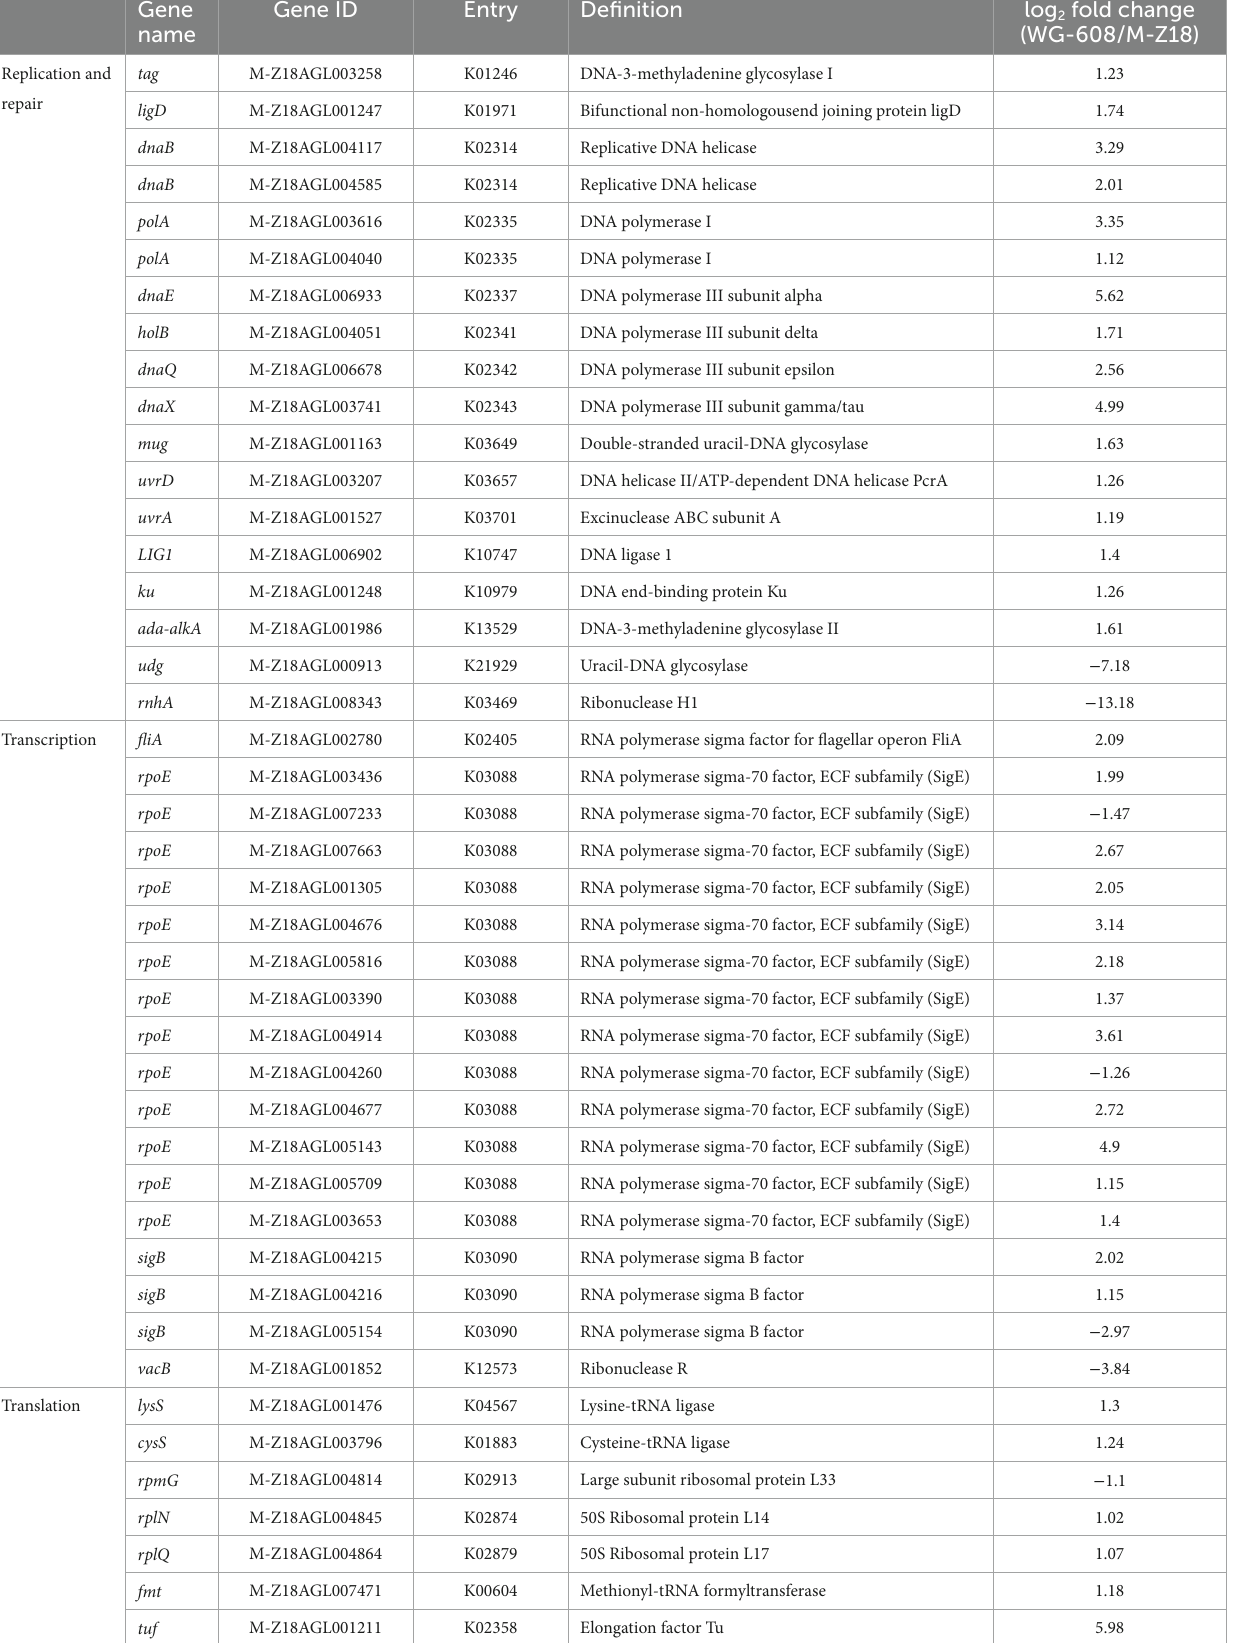
TABLE 1 Classification of differential expression genes in replication and repair, transcription and